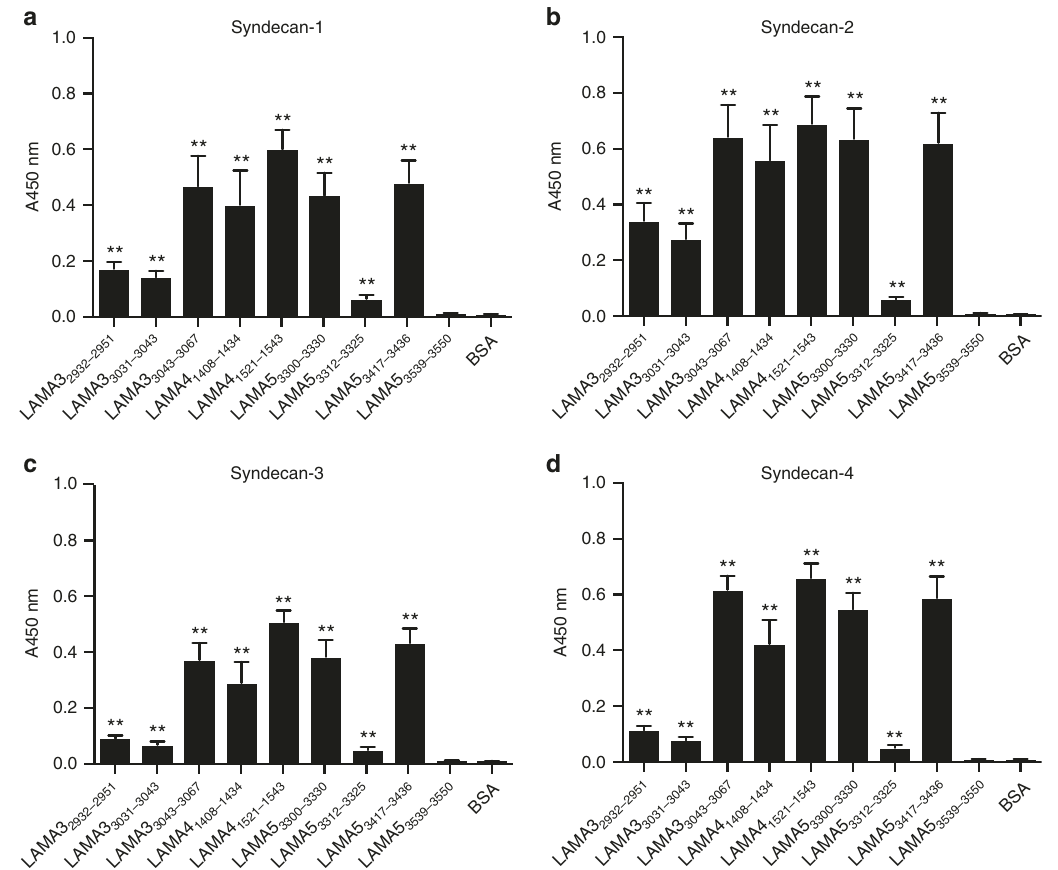
Fig. 5 Syndecans bind to laminin HBD derived from LAMA3, LAMA4, and LAMA5. Af fi nity of syndecans to chemically synthesized peptides derived from the laminin LAMA3, LAMA4, and LAMA5 LG domains. ELISA plates were coated with 10 µ g/mL laminin peptide and further incubated with 1 μ g/mL of a syndecan-1, b syndecan-2, c syndecan-3, or d syndecan-4. Bound syndecans were detected using an antibody against histidine-tag on the recombinant syndecans ( n = 8, mean ± SEM). Statistical analyses were performed using the Mann – Whitney U test by comparing the signals obtained from the laminin peptide- and the BSA-coated wells. * p < 0.05, ** p < 0.01. Two experimental